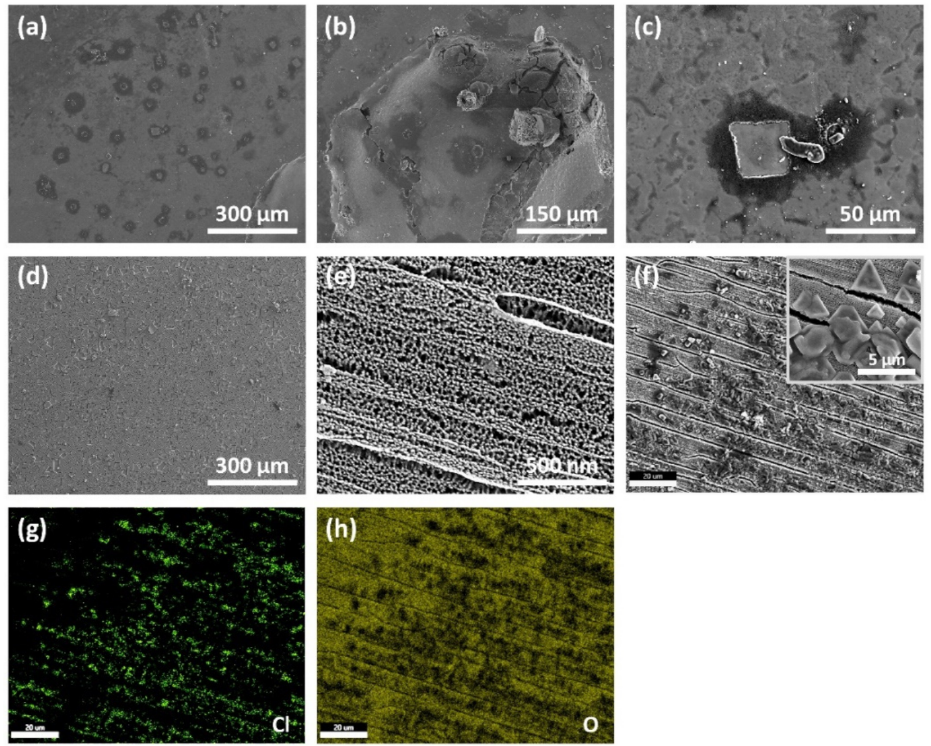
Figure 8. Surface FESEM images of welded SS ( a – c ). and of heat-treated anodized welded SS ( d – f ) after accelerated corrosion test. EDX characterization of crystals ( f ) on the heat-treated anodized welded SS surface ( g , h